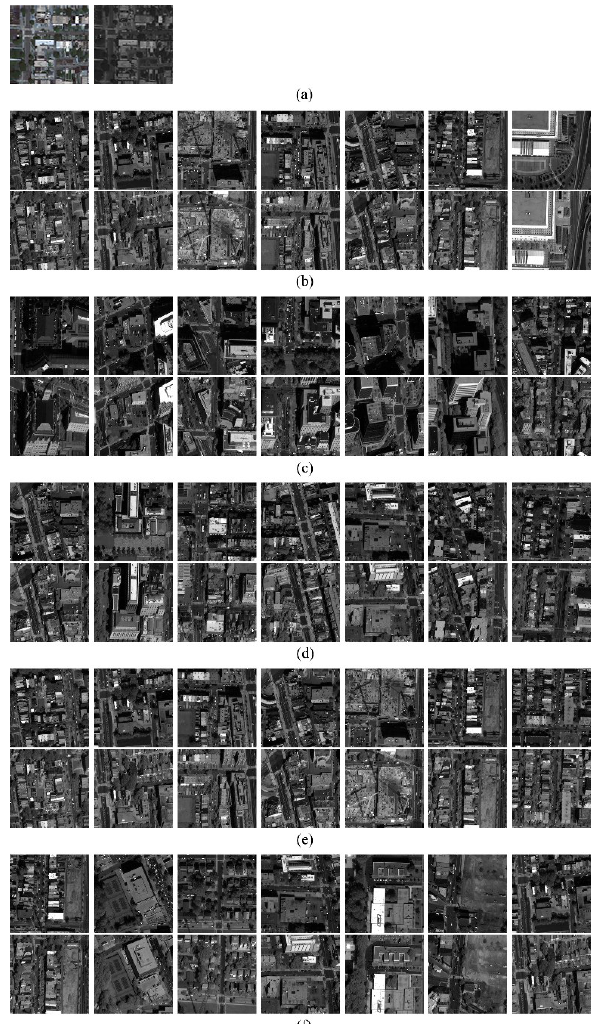
Figure 5. Results by our method and other four methods. (a) Query multispectral image and produced lightness image. (b) Image1-based method. (c) Image2-based method. (d) Our method. (e) Ortho-based method. (f) NRFCM-based method.